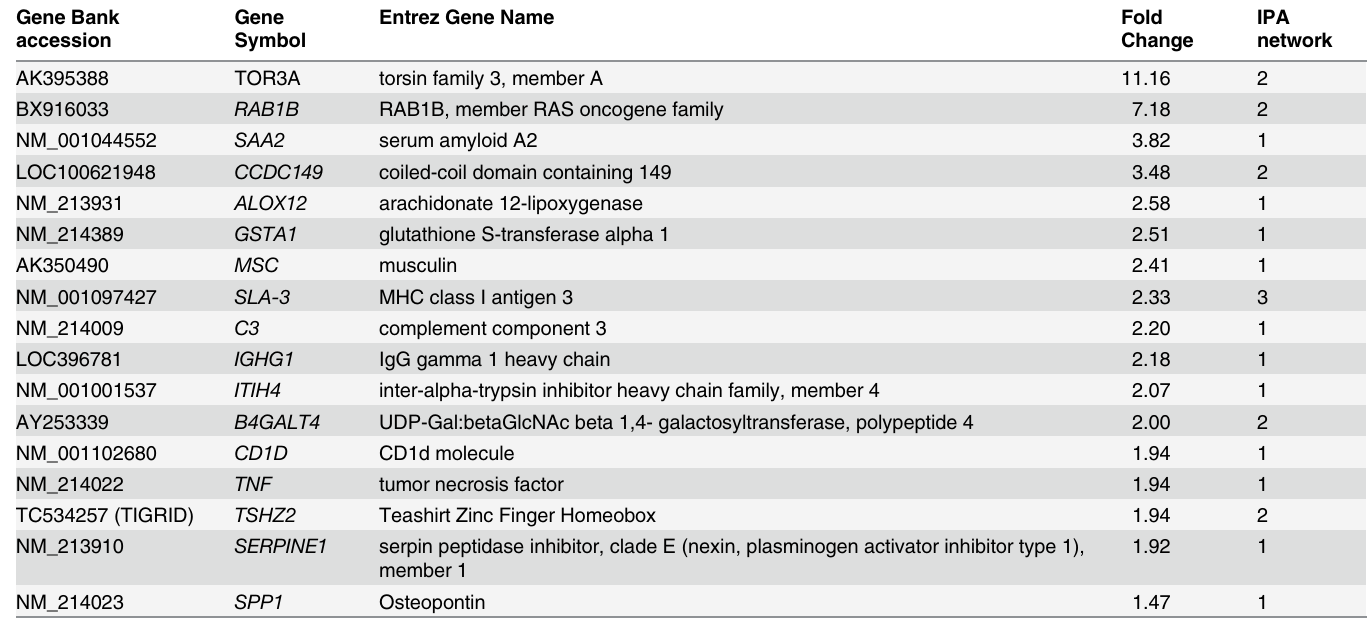
Table 2. Genes up-regulated in oviduct in artificially inseminated sows.